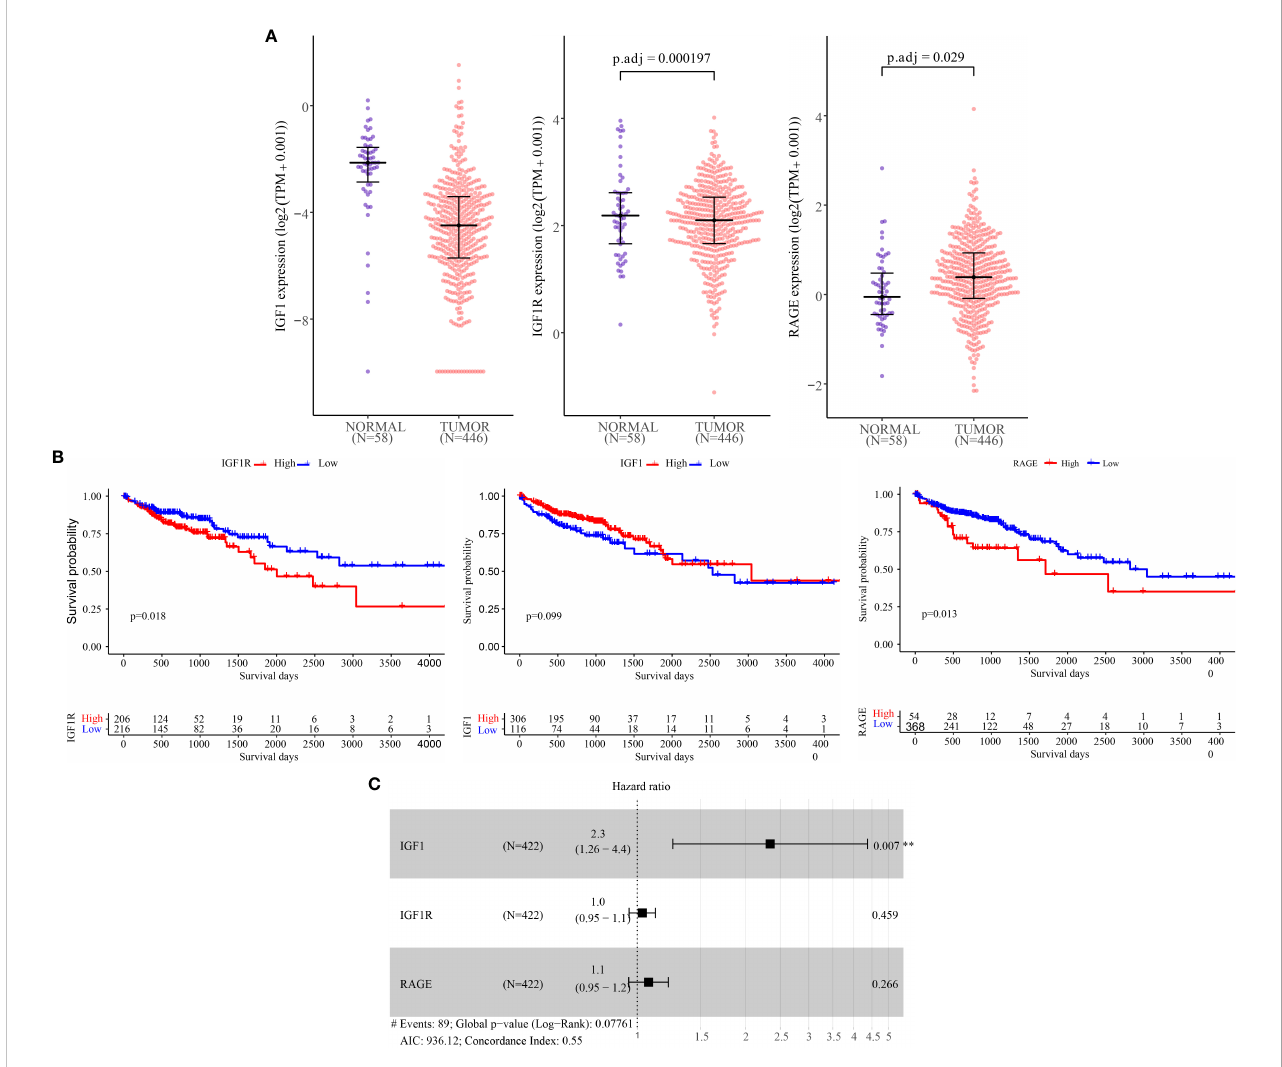
FIGURE 1 IGF-1, IGF-1R and RAGE mRNA levels and prognostic value analysis in CRC tissues according to RNA − Seq data from TCGA Data Bank. (A) Expression of IGF-1, IGF-1R and RAGE in normal colon tissues (n = 58) and according to tumor stage of CRC (n = 446). (B) Kaplan-Meier plots of overall survival (C) Independent risk factor analysis. ** Represents “ p ≤ 0.01